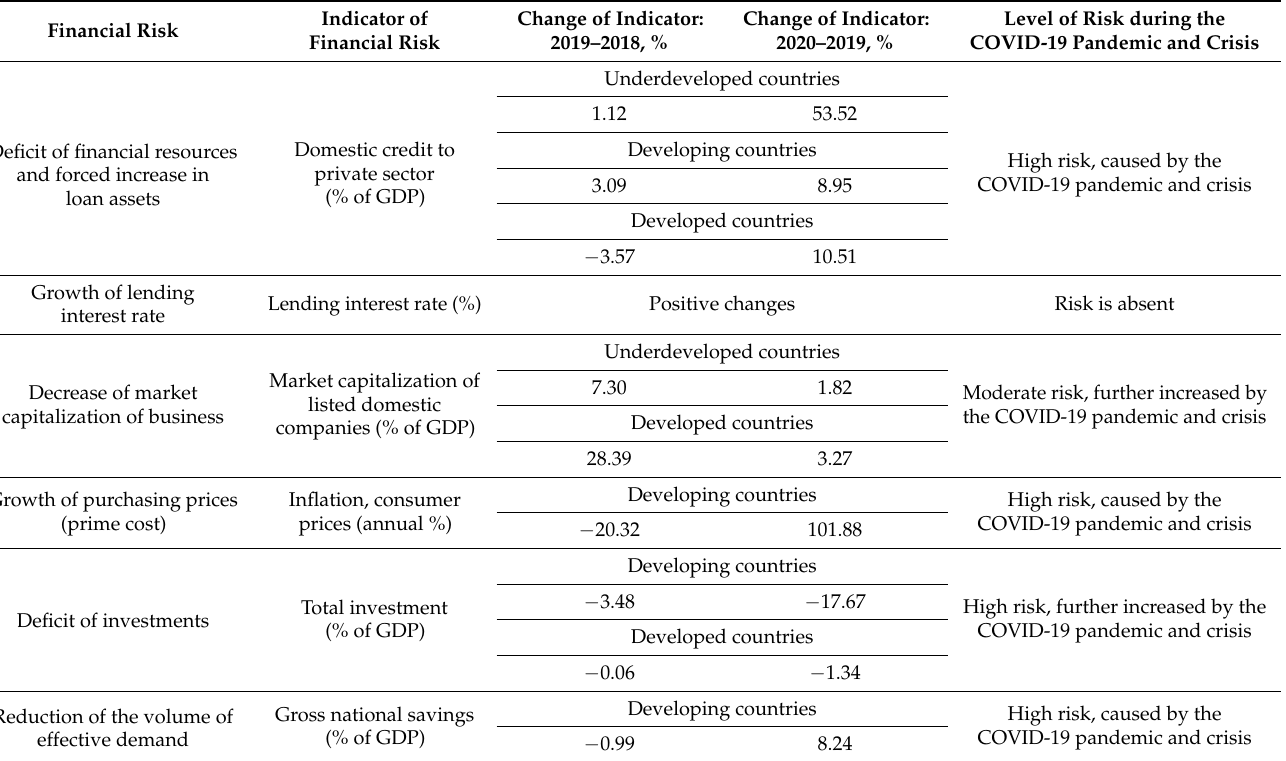
Table 5. Analysis of the level of financial risks and the impact of the COVID-19 pandemic and crisis on